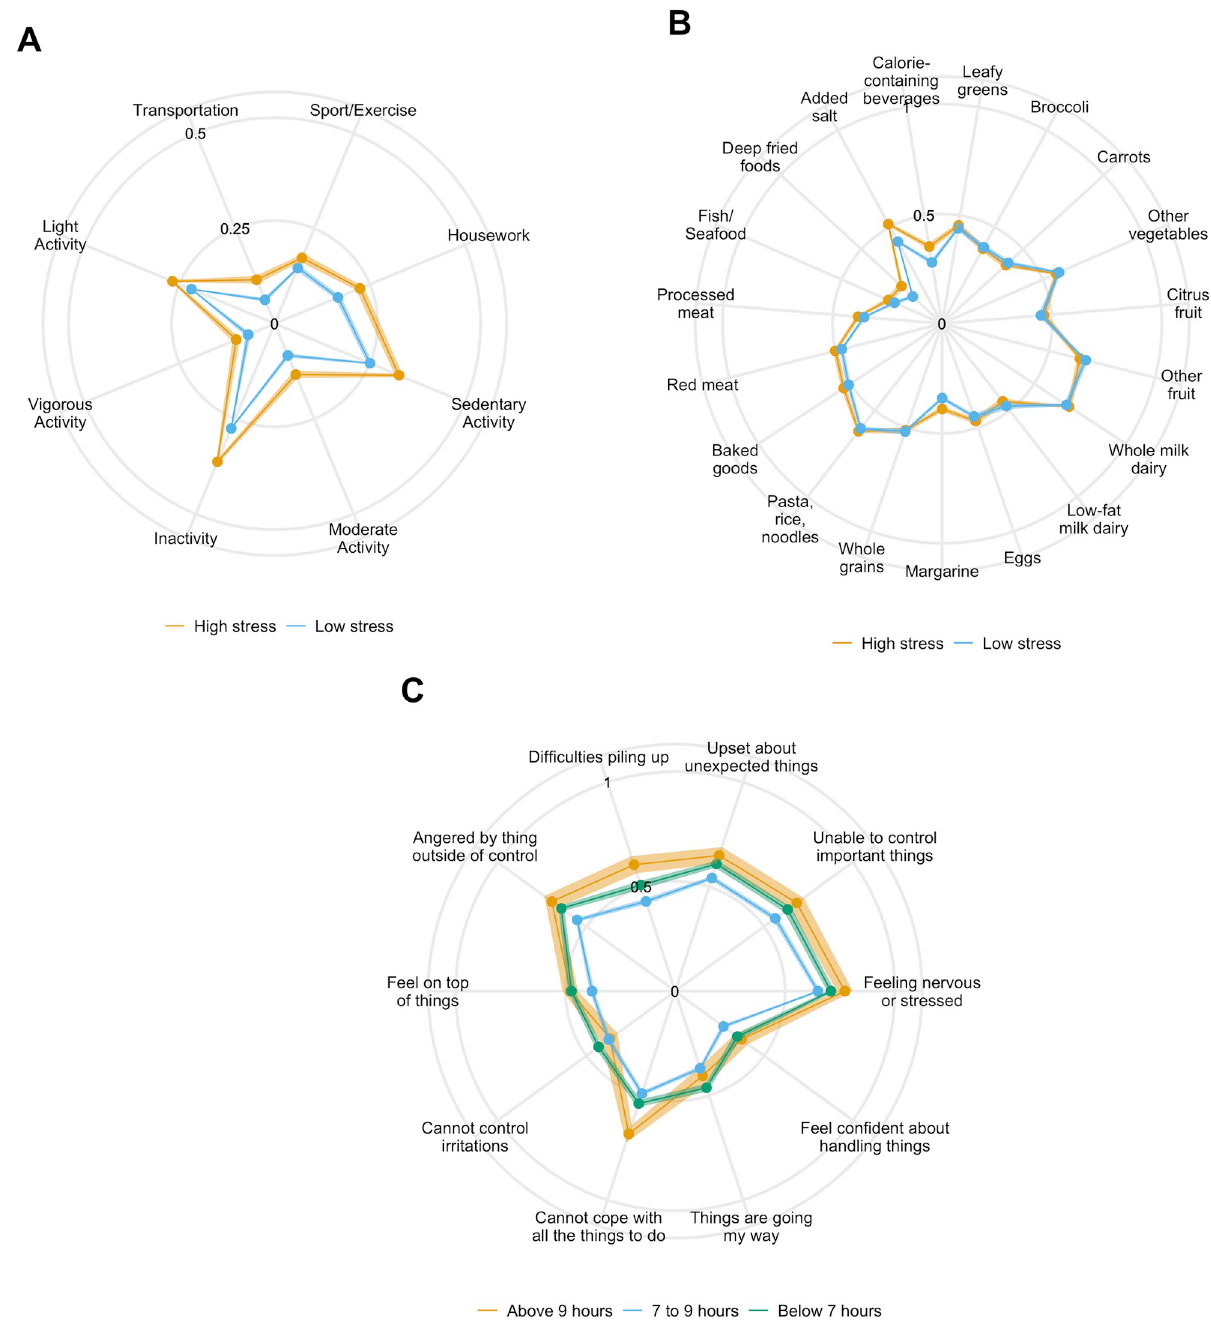
Fig 4. Distribution of mean responses by target class. A) Pregnancy Physical Activity Questionnaire features B) PrimeScreen features and C) Perceived Stress Scale features. Responses have been normalized to range from 0–1.